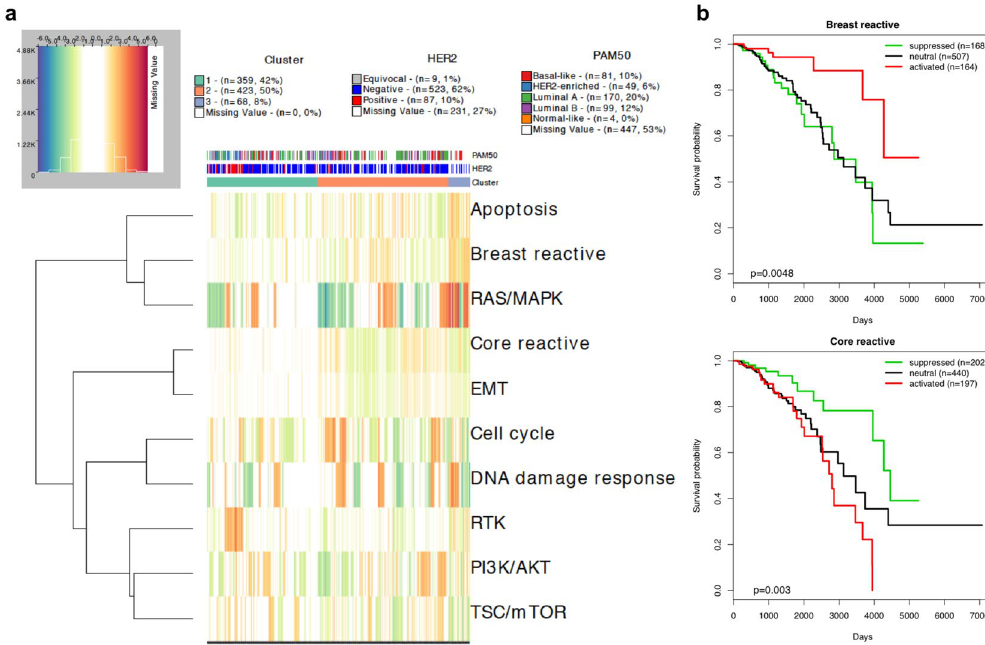
Figure 4. Concordance with known clinical subtypes of breast cancer (BRCA). ( a ) Heatmap depicting combined activated and suppressed PRECISE scores across 878 BRCA patients located in clusters C1, C2, and C3. The combined scores are signed by PRECISE statuses, -1 (suppressed), 1 (activated), or 0 (neutral). The signed scores are indicated on a suppressed-neutral-activated scale (blue-white-red). ( b ) Kaplan-Meier curves for the three groups of BRCA patients according to the PRECISE statuses, suppressed (green), neutral (black), and activated (red) for breast reactive and core reactive